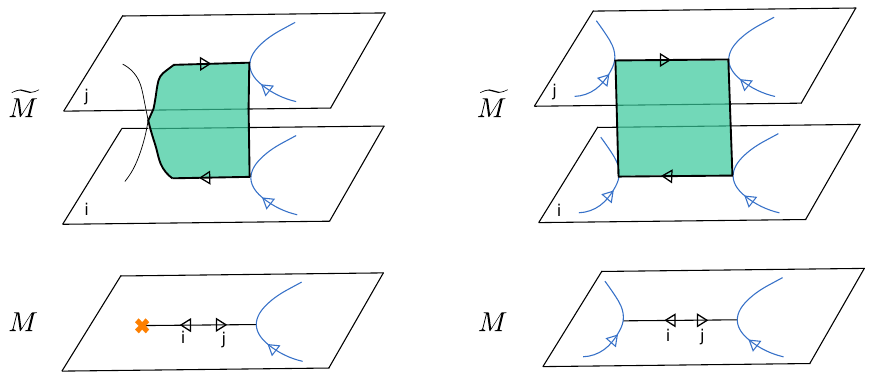
Figure 1 . The interpretation of detour (left) and exchange (right) as M2-branes in T (cid:3) M bounded by f M and the conormal to L